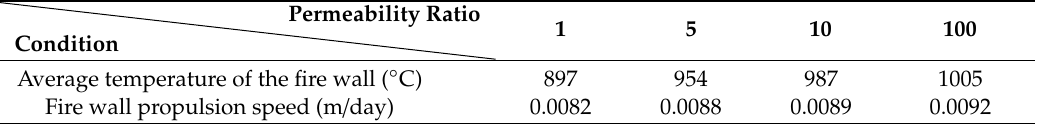
Table 17. Characteristic parameters of fire wall under di ff erent permeability ratio.